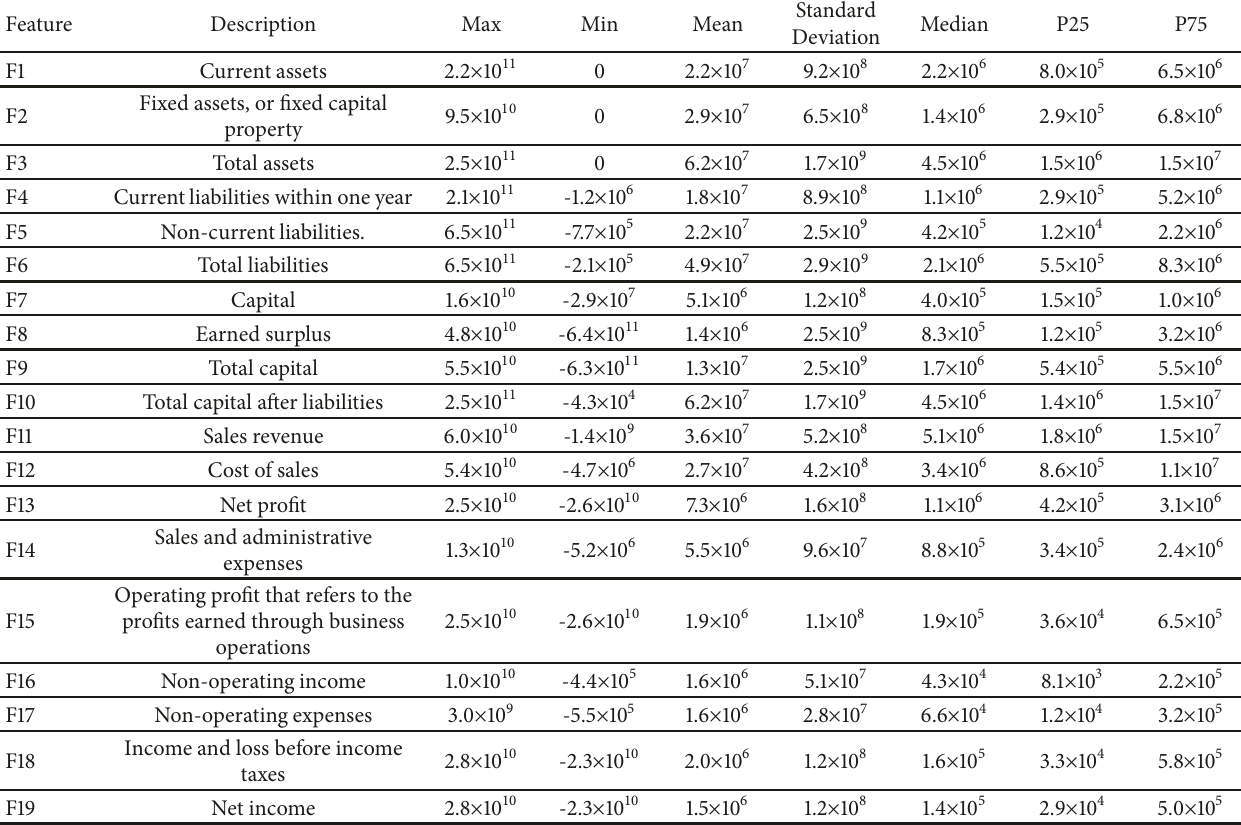
Table 1: The statistical information of